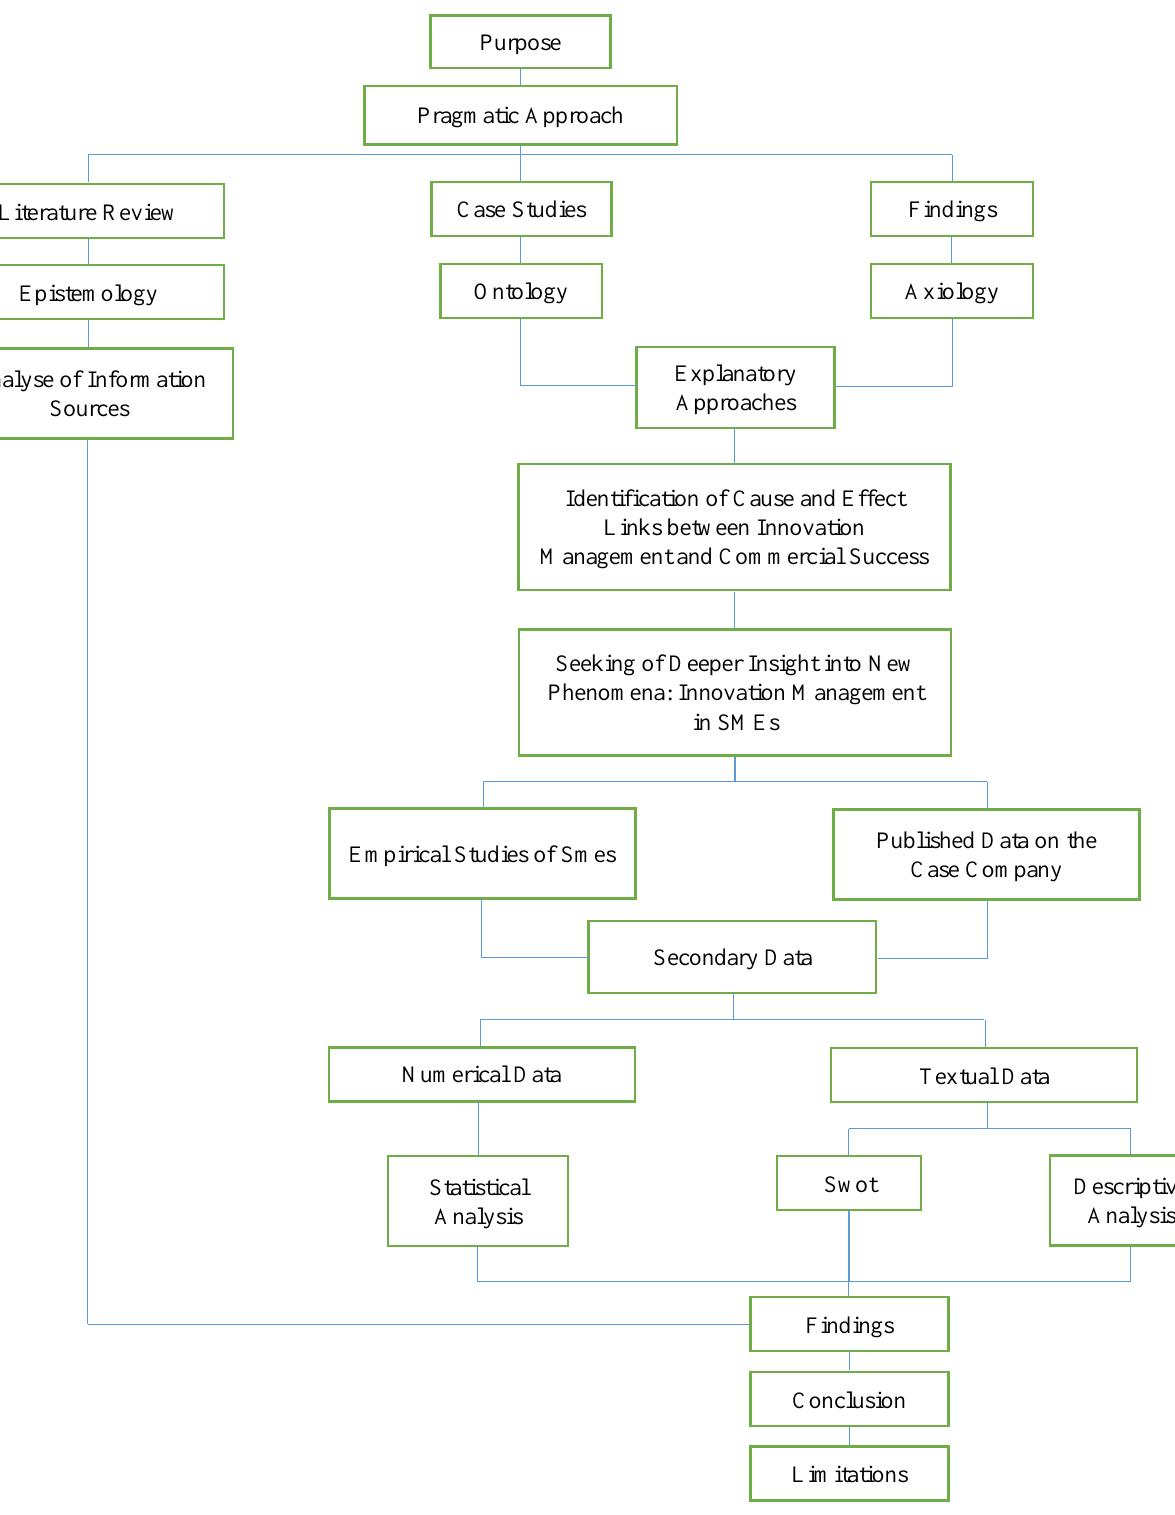
Figure 1. Methodology